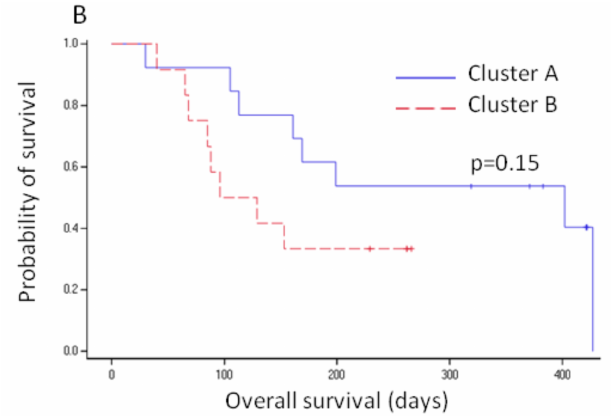
Figure 4. Kaplan-Meier curves of the ( A ) progression-free survival and ( B ) overall survival proportion according to basal kinomic profile. Blue and red lines indicate patients in clusters A and B, respectively. Small crosses represent censored patients. Median progression free survival (PFS) was 92 (38–158) and 50 (28–135) days in clusters A and B, respectively (log-rank test p -value; p = 0.70). Median OS was 402 (113–427) and 112.5 (65-not determined) days in clusters A and B, respectively (log-rank test p -value; p =